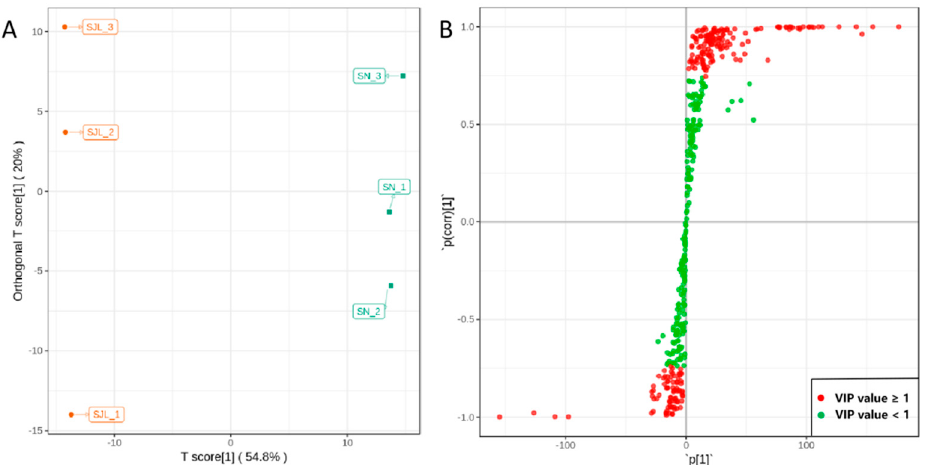
Figure 3. Orthogonal projections to latent structures discriminant analysis (OPLS-DA). ( A ): Score scatter plots of the OPLS-DA model for SJL vs. SN; ( B ): S-plot of the OPLS-DA model for SJL vs. SN, red dots denote metabolites with VIP value ≥ 1, while green dots mean metabolites with VIP value < 1.